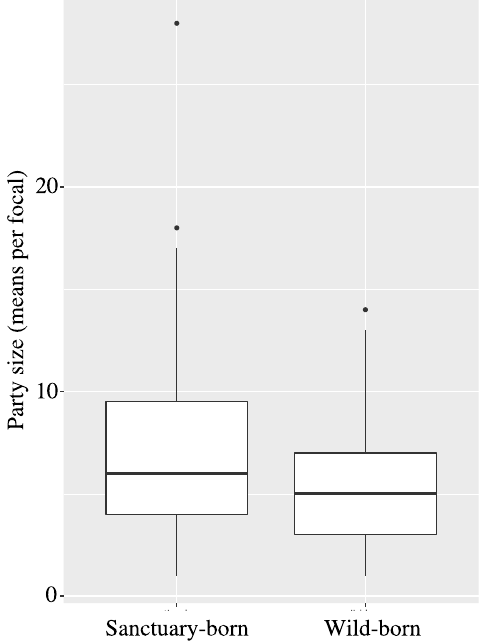
Figure 2. Party sizes for sanctuary-born versus wild-born chimpanzees at the Chimfunshi Wildlife Orphanage Trust, Zambia. Medians are represented by the bold, horizontal lines within the boxes (sanctuary-born = 7.36; wild-born = 6.46). The boxes represent the interquartile range (IQR), the vertical lines attached to the boxes represent Q1 − 1.5 IQR (lower) and Q3 + 1.5 IQR (upper).